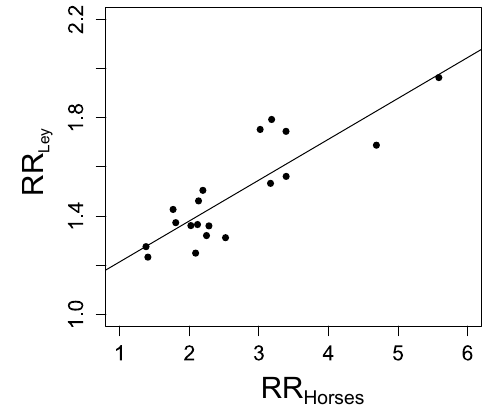
Figure 6. Change in ley as a proportion of total agricultural area (RR Ley ) as a function of the increase in horse population (RR Horses ) for each Swedish county,